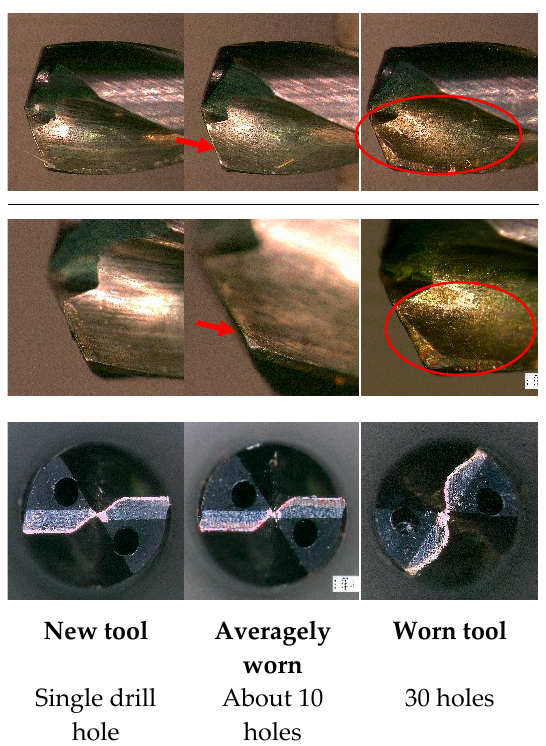
Figure 15. Discoloration of cutting tool tip due to high generated temperatures at the edges.